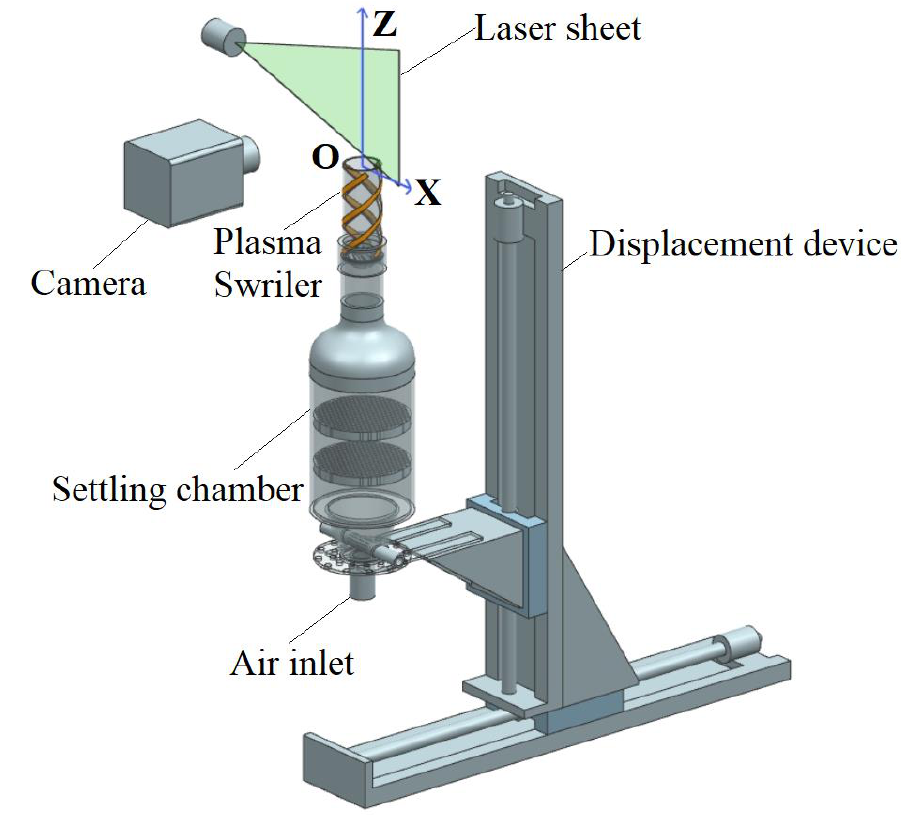
Figure 2. Schematic of the experimental setup.